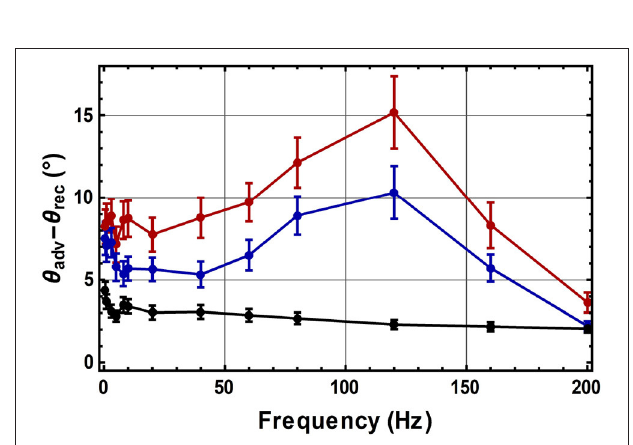
FIGURE 8 | Contact angle hysteresis as a function of frequency for the three PEO solutions with different molecular weights for 1 p = 225 Pa (red line: PEO1; blue line: PEO5; black line: